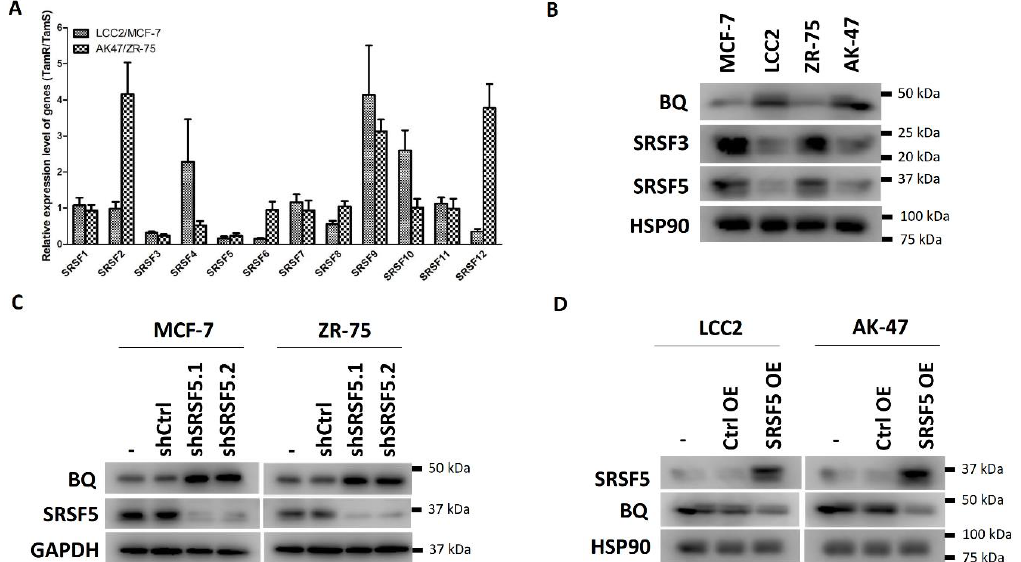
Figure 1. Expression of BQ modulated by SRSF5 in breast cancer. ( A ) SRSF5 and SRSF3 down- regulated in both LCC2 and AK47 cell lines. LCC2 and AK-47 are high BQ-expressing cell lines with tamoxifen (TAM) resistance, while MCF-7 and ZR-75 are TAM-sensitive cell lines with low BQ expression. Abbreviations for TAM-resistant and TAM-sensitive are TamR and TamS, respectively. TamR/TamS indicates the comparison between TamR cell lines (LCC2 and AK-47) and TamS cell lines (MCF-7 and ZR-75). qPCR was used to determine the expression of SRSF1-12. Actin was employed as the internal control. ∆∆ CT method was used to evaluate the relative gene expression level. The expression of each SRSF was compared between TAM-resistant and TAM-sensitive cell lines. LCC2 and AK-47 were derived from MCF-7 and ZR-75, respectively. The comparison was made between LCC2 vs. MCF-7 and ZK-47 vs. ZR-75. Results are shown as mean ± SD from three independent experiments. ( B ) Protein expressions of BQ, SRSF3 and SRSF5 determined by Western blot in different cell lines. HSP90 was the loading control. ( C ) Knockdown of SRSF5 enhanced protein expression of BQ in MCF-7 and ZR-75. GAPDH was the loading control. ( D ) Overexpression of SRSF5 reduced BQ expression. LCC2 and AK-47 were stably transfected with pCMV-Myc-SRSF5 (SRSF5 OE) or pCMV (Ctrl OE). The expression of the protein candidates was determined by Western blot with HSP90 or GAPDH as the loading control. Results were obtained from four independent experiments.